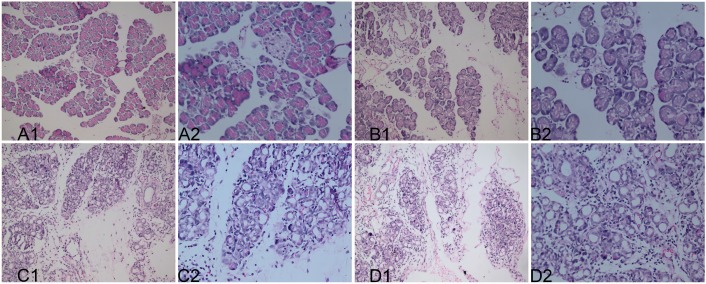
Pathological examination of pancreatic tissues by hematoxylin and eosin staining. (A) Day 7 group tissues. Slight atrophy of the pancreatic gland with infiltration by low frequencies of inflammatory cells and fibrosis. Total score = 5; fibrosis score = 1; and inflammatory cell infiltration score = 1. (B) Day 14 group tissues. Clear atrophy of the pancreatic gland and moderate edema of the pancreatic tissues, with inflammatory cell infiltration and fibrosis. Total score = 7; fibrosis score = 2; and inflammatory cell infiltration score = 2. (C) Day 21 group tissues. Clear atrophy of the pancreatic gland and moderate edema of the pancreatic tissues, with infiltration with relatively high numbers of inflammatory cells and fibrosis. Total score = 7; fibrosis score = 2; and inflammatory cell infiltration score = 2. (D) Day 35 group tissues. Clear atrophy of the pancreatic gland and evident edema of the pancreatic tissues, with infiltration with high numbers of inflammatory cells and fibrosis. Total score = 11; fibrosis score = 2; and inflammatory cell infiltration score = 3. A1-D1, magnification ×200; A2-D2, magnification ×400.